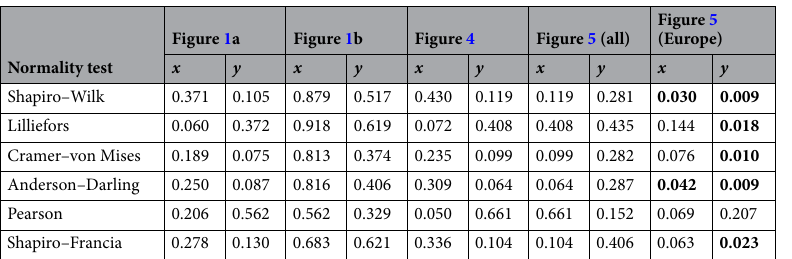
Table 1. P -values from normality tests performed for data for which Pearson’s correlation coefficient is estimated. Columns labeled x and y correspond to projections of data points onto the horizontal and the vertical axis (marginal distributions), respectively. Values of p < 0.05 (bold) indicate violation of the normality